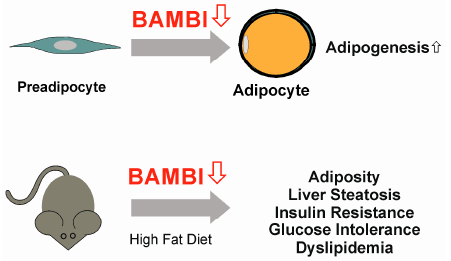
adiposity and metabolic Figure 6. BAMBI down-regulation in adipocytes promotes adipogenesis and is associated with ad- iposity and metabolic disease.